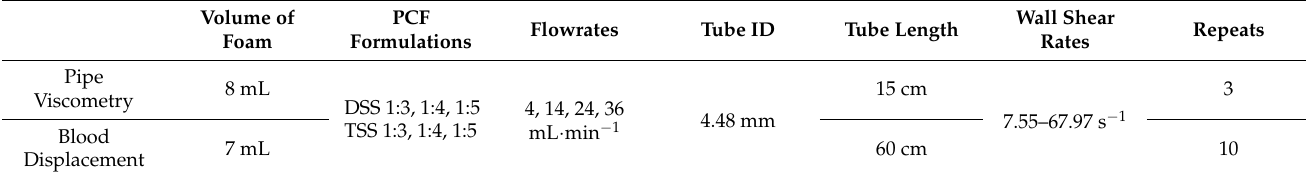
Table 1. Summary of experimental parameters of pipe viscometry and blood displacement